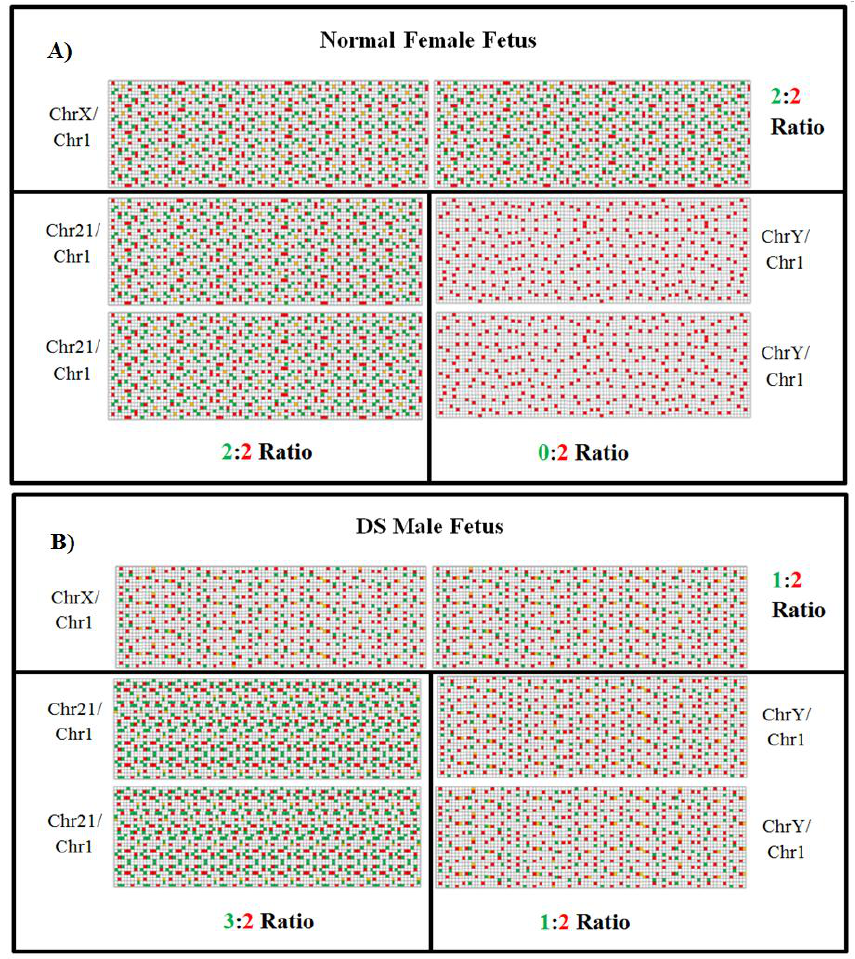
Figure 5. False-color images of microfluidic digital PCR chips. FAM signal is shown in green, which represents the target chromosome (chromosome X, Y or 21), and HEX signal is shown in red, which represents the reference chromosome (chromosome 1). Yellow squares indicate overlapping of HEX and FAM. ( A ) Euploid female fetus (46 XX). The ratio of chromosomes X and 21 are equal to reference chromosome 1 (2:2). There is no target Y chromosome identified. ( B ) DS male fetus (47 XY + 21). Ratio of chromosomes Y and X is half of reference chromosome 1 (1:2 ratios for X or Y and chromosome 1, respectively). This fetus indicates an increase of chromosome 21 in comparison to reference chromosome 1 (3:2 ratio, respectively), indicating trisomy 21 (adapted from